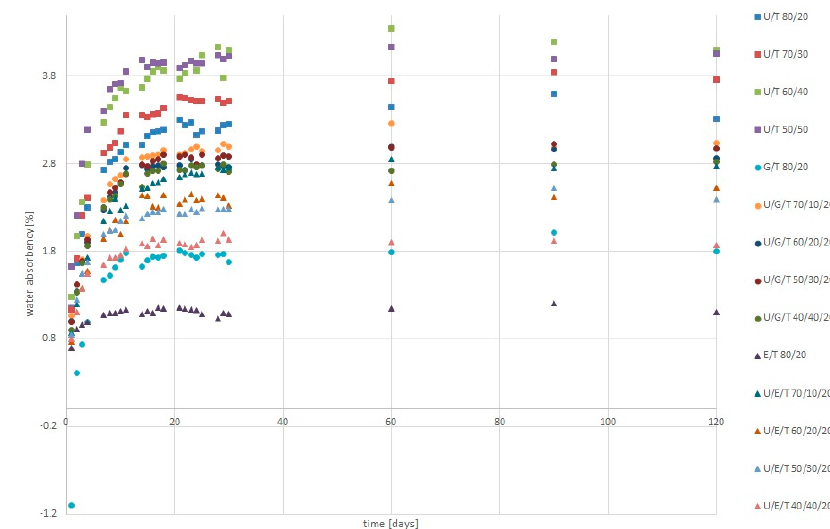
Figure 5. Dynamic water absorbency of tested matrices.